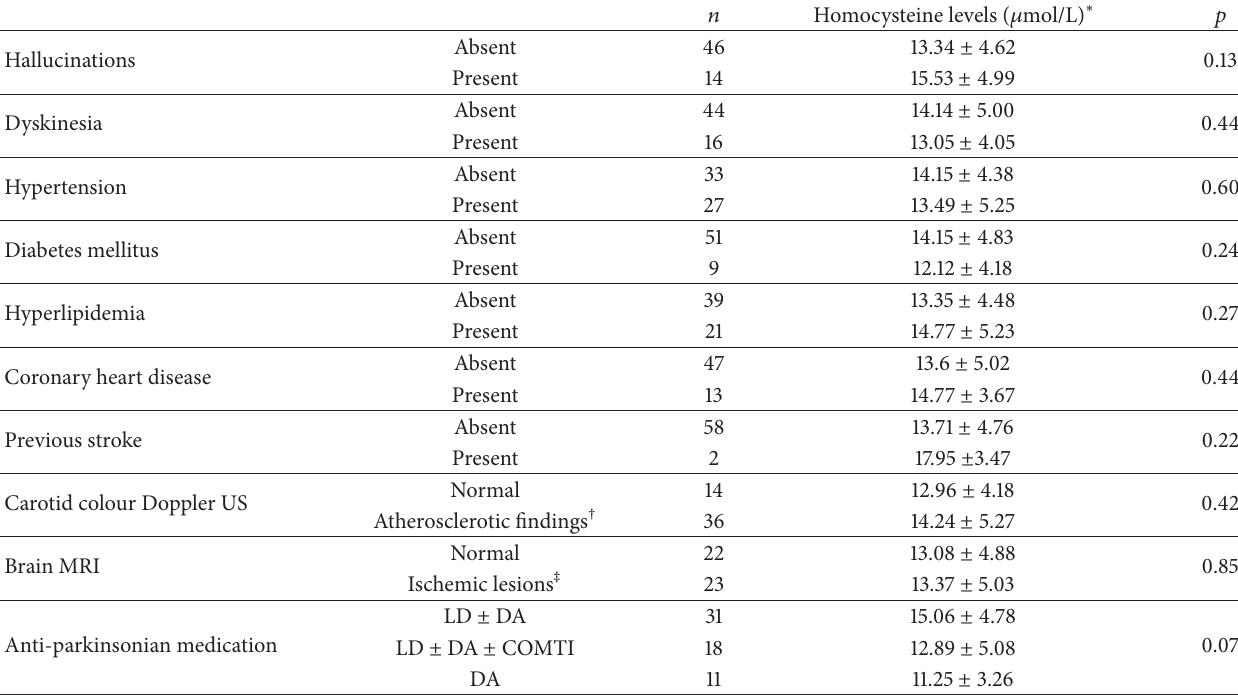
Table 3: Plasma homocysteine levels and their relationships with hallucinations, dyskinesia, vascular risk factors, carotid colour Doppler US, brain MRI findings, and anti-parkinsonian medication in patients with Parkinson’s disease.